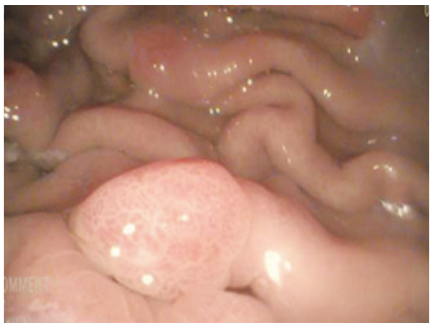
Figure 1: Endoscopic evaluation of the stomach demonstrating polyposis of the mucosa.